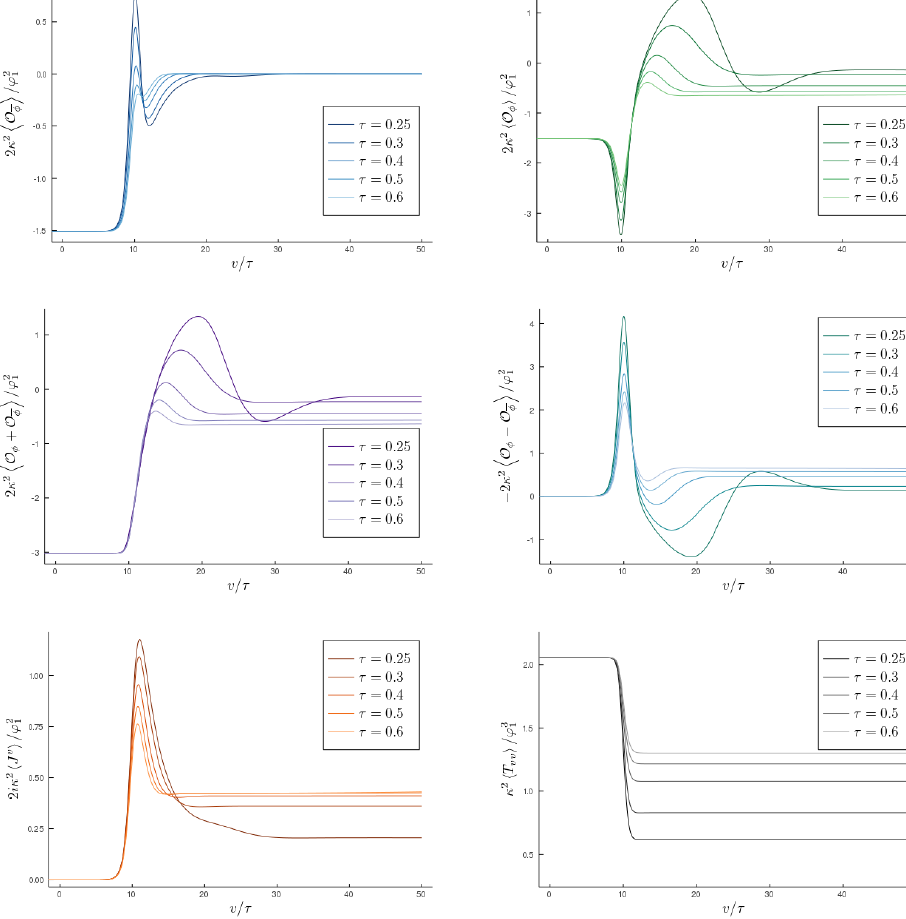
Figure 2: Expectation values 2.22 for a quench with profile 3.1 for several values of τ which interpolate between the Hermitian point ξ = 0 and the exceptional point i ξ = 1.0. We set v = 10 τ . Note that the current settles to a final equilibrium value f m different from 0. This feature is distinctive for the exceptional